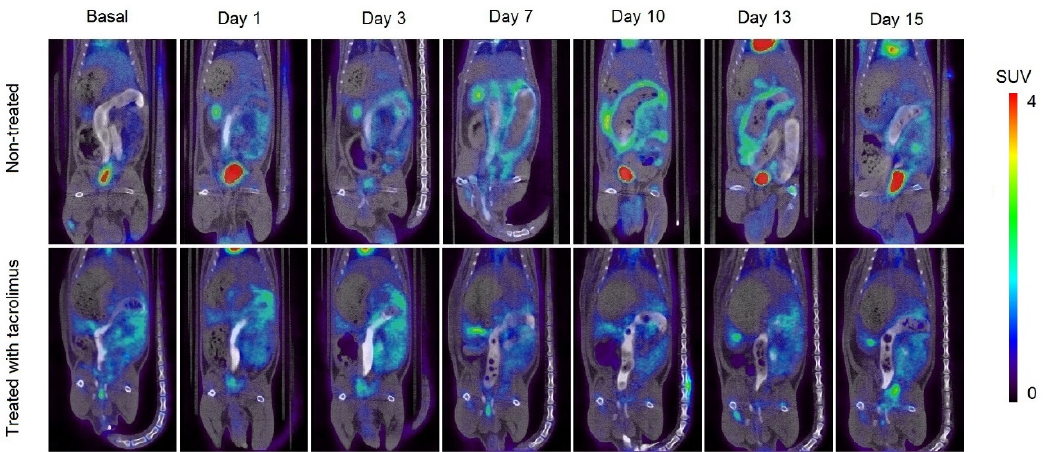
Figure 7. Longitudinal fused PET/CT images over time obtained from rats without treatment (13) after the colitis induction and treated with the 3D printed tacrolimus suppositories. The metabolic activity is coded on a color scale ranging from blue (low [ 18 F]FDG uptake) to red (high [ 18 F]FDG uptake).